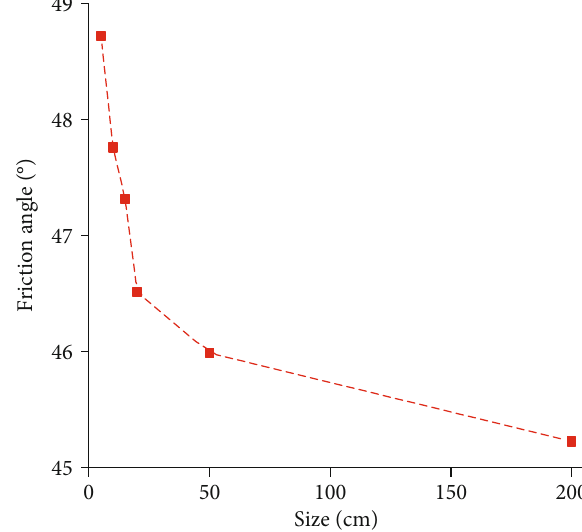
Figure 14: Relationship between friction angle and model